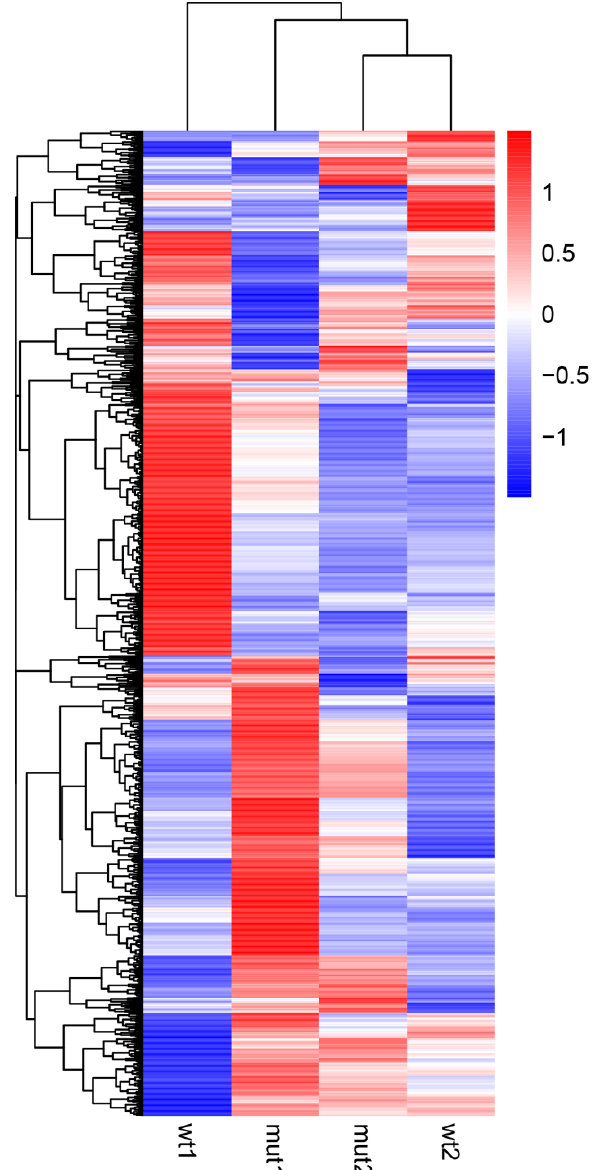
Figure 2. Hierarchical clustering of DEGs detected in WCS358 wild type and ∆ rclS mutant in exponential and stationary growth phase. Scaled log2 expression values are presented in red and blue indicating high and low expressions,